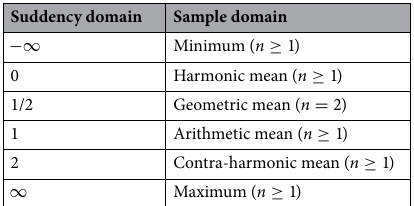
Table 1. Some special cases of suddency